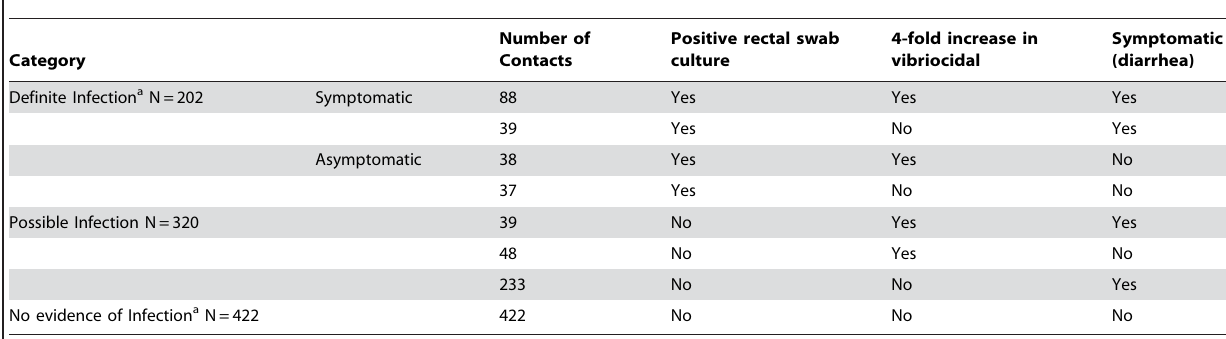
Table 1. Outcomes in 944 Household Contacts Completing 21 Days of Follow-up